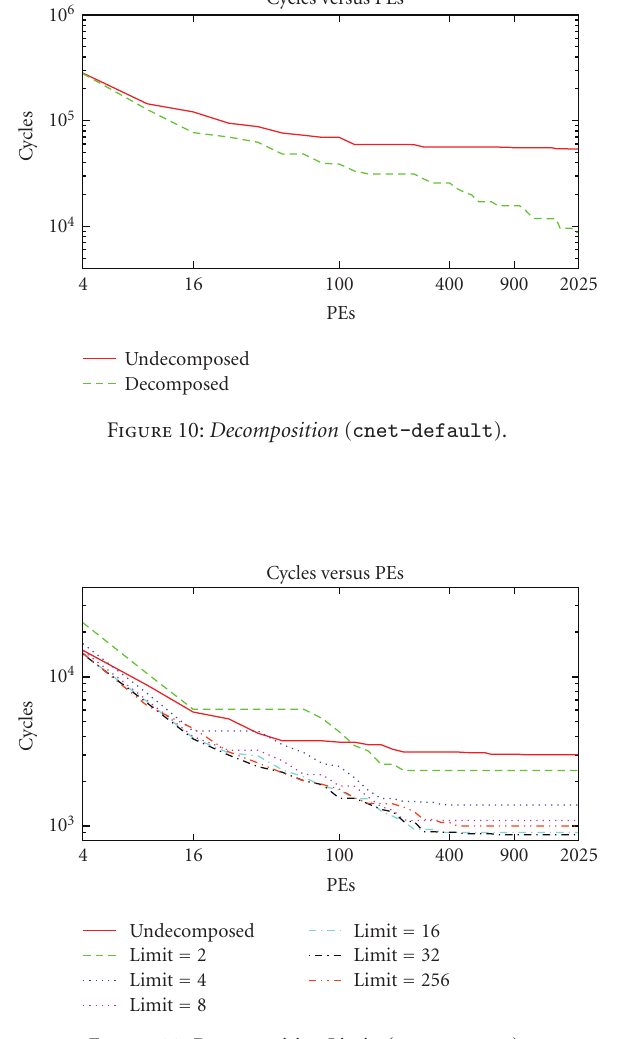
Figure 11: Decomposition Limits ( cnet-small ).